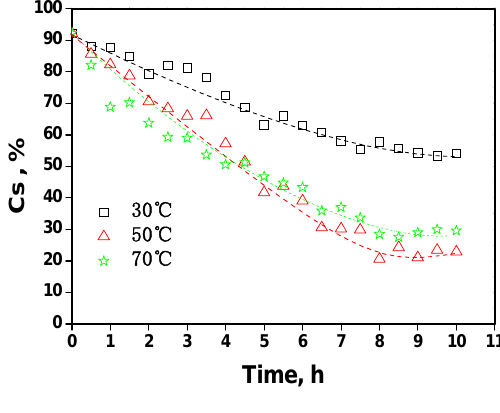
intensity of 002 peak of sample’s XRD) in MCC with phosphoric